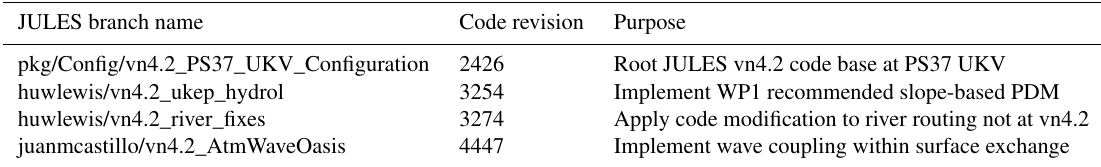
Table C2. Summary of JULES code branches merged and used in the UKA2/UKL2 and UKC2 system, containing relevant adaptations from the version 4.2 baseline code. Model codes are accessible via https://code.metoffice.gov.uk/trac/jules/wiki (Met Office, 2017h). Registered users can directly access each code branch at the revision used in UKC2 by following the direct code revision links